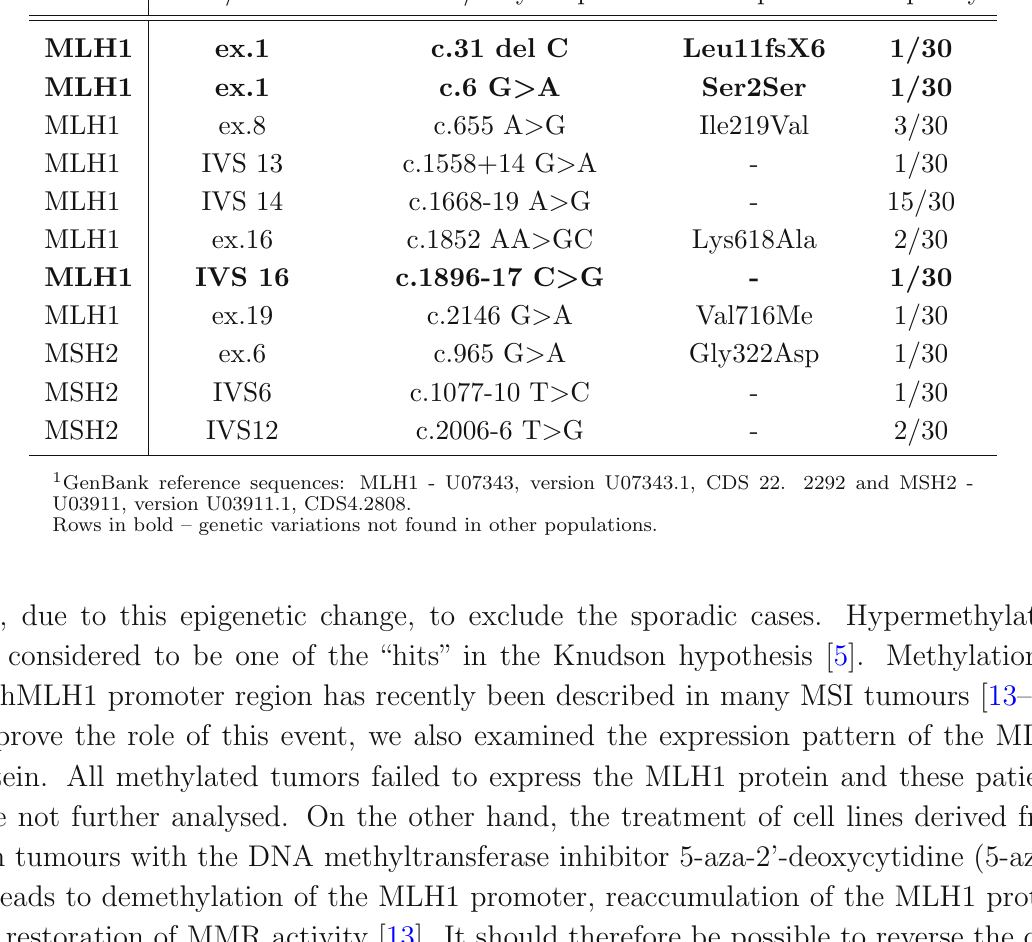
Table 1 MLH1 and MSH2 genetic variations, found in 30 MSI or LOH Bulgarian patients.